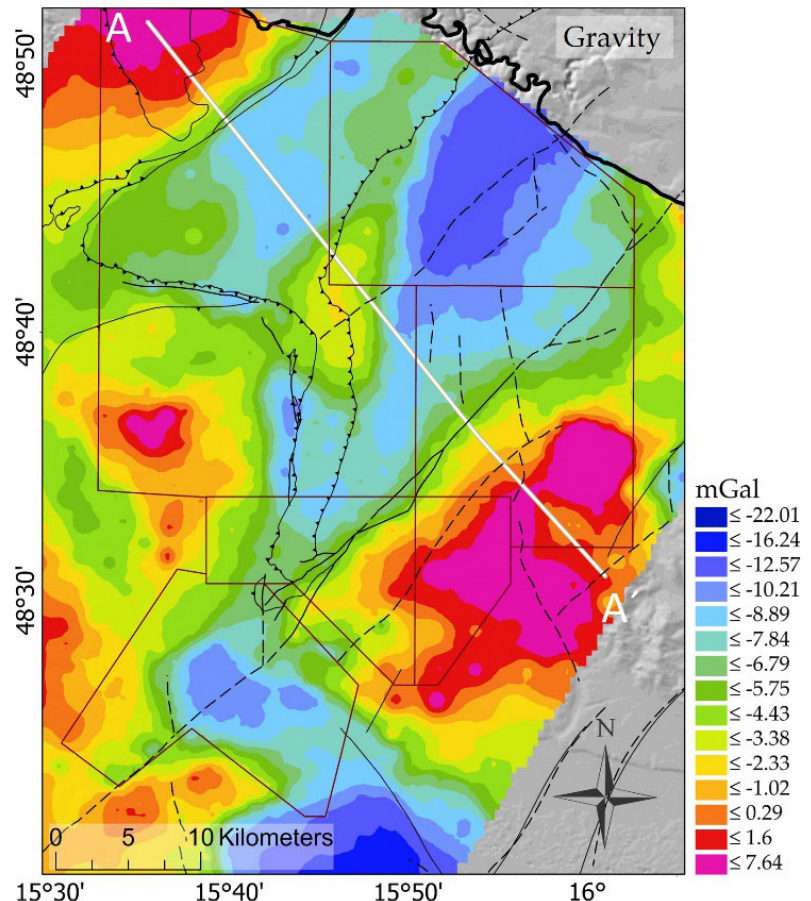
Figure 5. Bouguer anomaly map calculated with reference density 2670 kg × m −3 (data provided by BEV). For processing details, see description in text. Outline of airborne geophysical data sets are shown for reference. Black lines indicate geological faults; see legend in Figure 1b for details. Background map: Lidar image with a 10 × 10 m resolution.